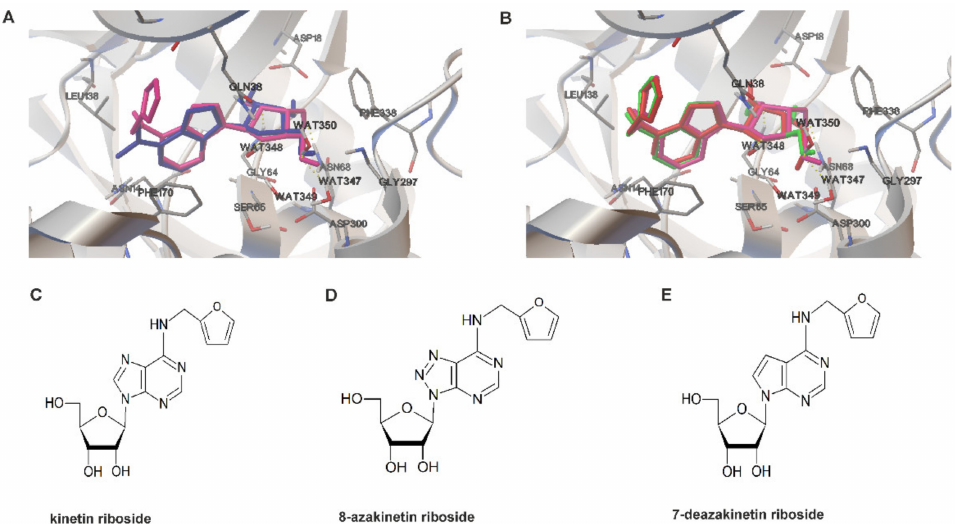
Figure 2. Determination of kinetin riboside analogues featuring similar affinity for adenosine kinase. ( A ) Juxtaposition of docked poses of KR (magenta) and the reference ligand dimethyladenosine (blue) in the binding cavity of the modeled semi-open conformation of human ADK structure represented by ribbons. Hydrogen bonds are depicted as yellow dotted lines. Residues in close contact to ligands are shown as sticks. ( B ) Juxtaposition of docked poses of KR (magenta), 8-azaKR (red), and 7-deazaKR (green) in the binding cavity of the modeled semi-open conformation of human ADK structure represented by ribbons. Hydrogen bonds are depicted as yellow dotted lines. Residues in close contact to ligands are shown as sticks. ( C – E ) Structure of kinetin riboside and its two derivatives, 8-azakinetin riboside and 7-deazakinetin riboside, with similar affinity binding to human